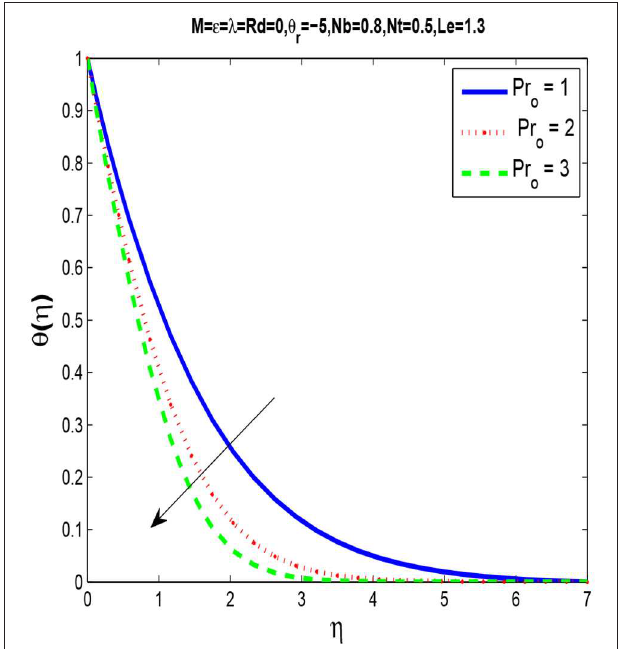
FIGURE 11 | Concentration profile φ ( η ) for different Le ( For Case B).